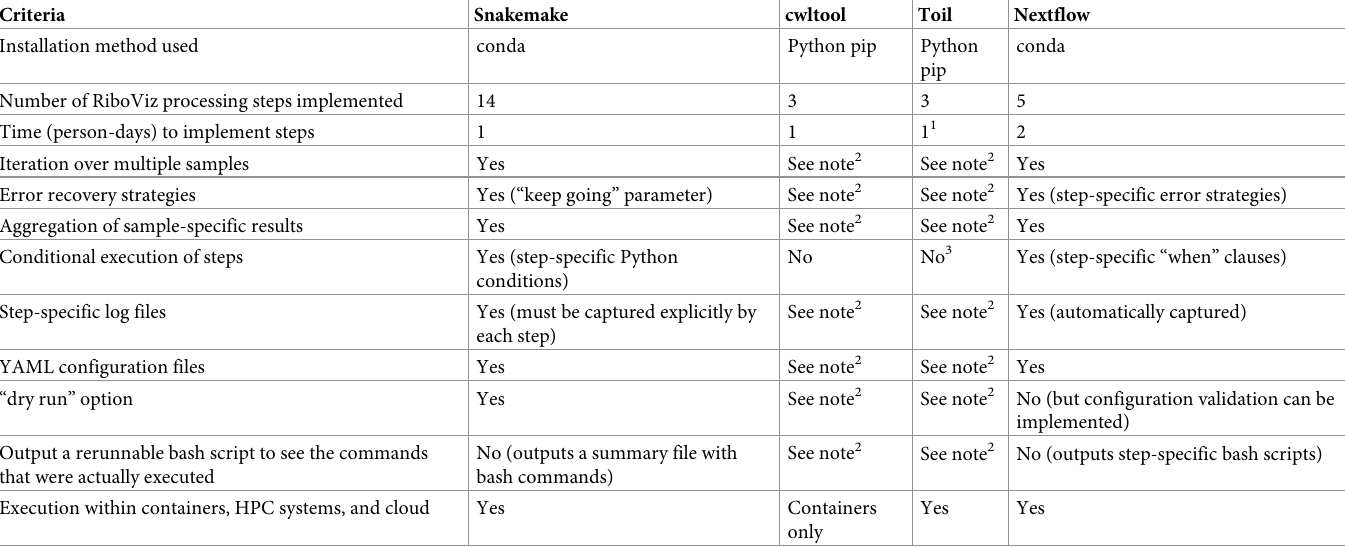
Table 5. Summary of workflow management systems and objective evaluation